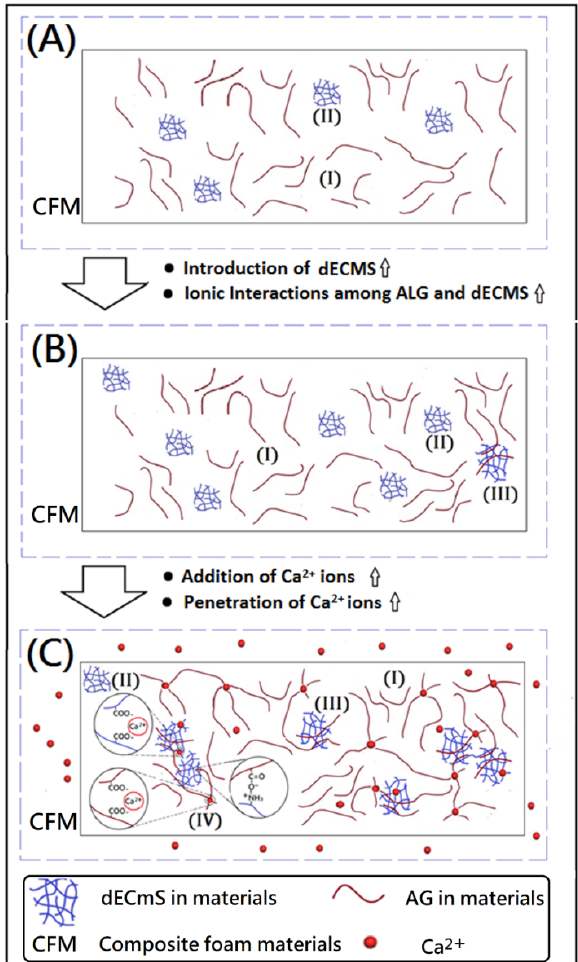
Figure 6. Proposed model of ionic associations among Ca 2+ ions, AG molecules, and dECmS molecules within designed composite foam materials (CFM): ( A ) new composite foam materials with a small amount of dECmS, ( B ) new composite foam materials with a large amount of dECmS, and ( C ) new cross-linked composite foam materials with a large amount of dECmS.